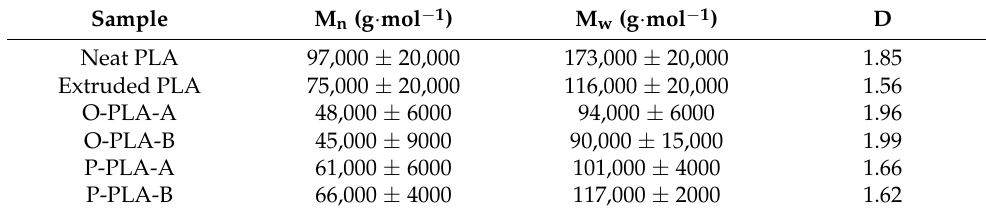
Table 5. SEC analysis on neat and functionalized PLA with different alkoxysilane concentrations.